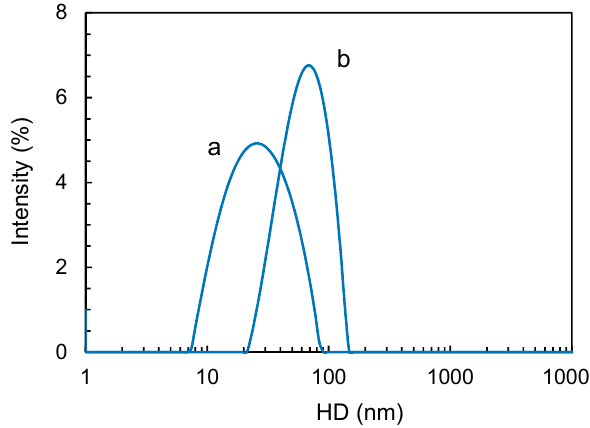
Figure 6. Dynamic light scattering (DLS) size distribution profiles of Ag-NPs obtained from red currant waste (RCW) extracts at 40 ◦ C and pH 12 (a) or pH 9 (b) (other conditions: Reaction time = 5 h; Silver-to-polyphenol ratio = 10 mol Ag + /mol GAE). Table 1. Hydrodynamic diameter (HD) and zeta potential ( ζ ) of Ag-NPs obtained from bilberry waste (BW) and red currant waste (RCW) extracts at different pH (other conditions: T = 40 ◦ C; Reaction time = 5 h; Silver-to-polyphenol ratio = 10 mol Ag + /mol GAE). HD (nm)